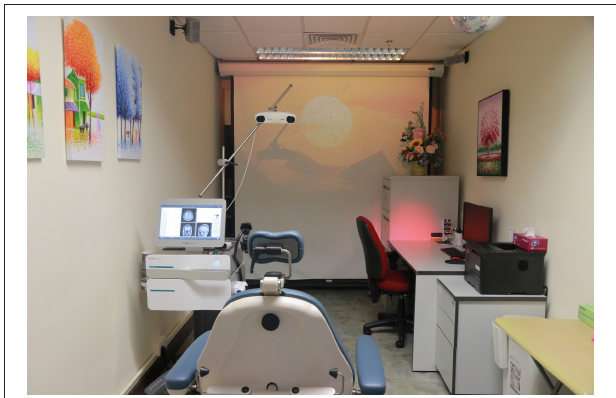
FIGURE 4 | Transcranial Pulse Stimulation System, and TPS treatment venue, The Hong Kong Polytechnic